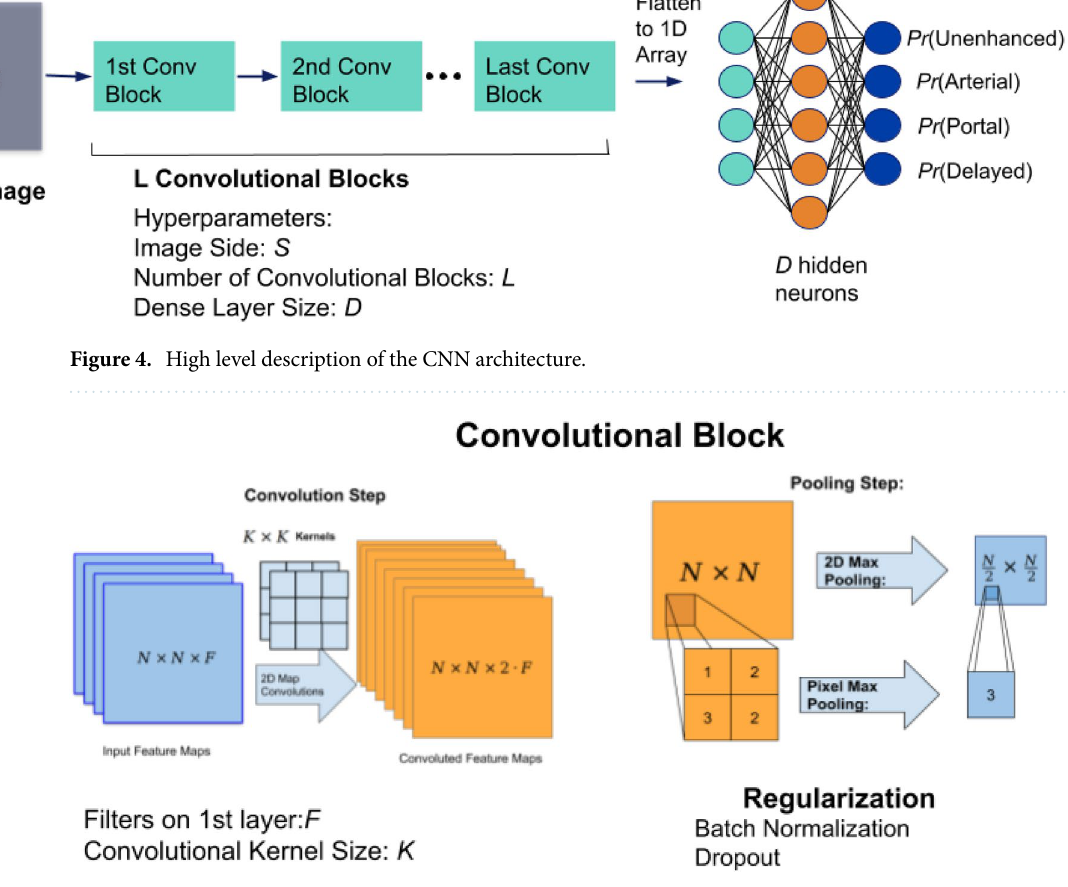
Figure 5. Convolutional block with the convolutional and pooling steps, followed by regularization. N input feature